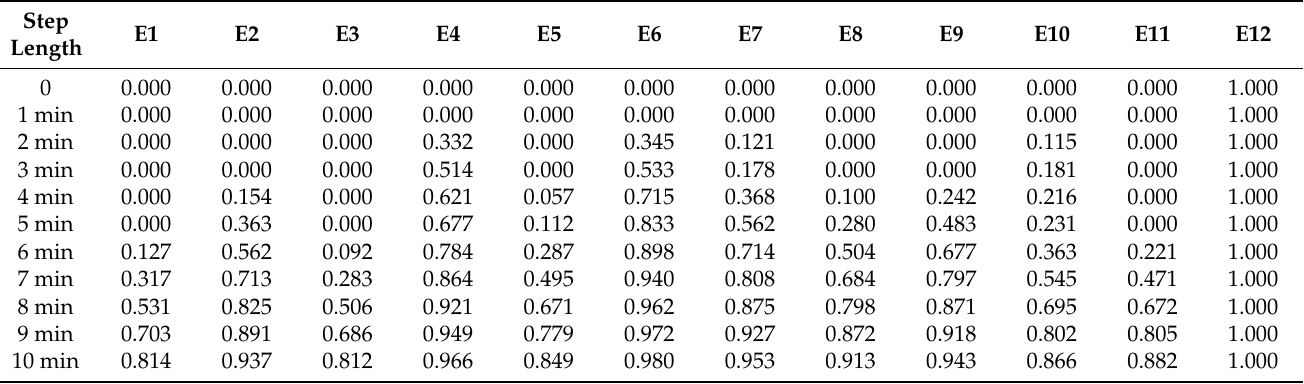
Table 7. Fire probability of equipment in an engine room at each time step when the initial fire source is